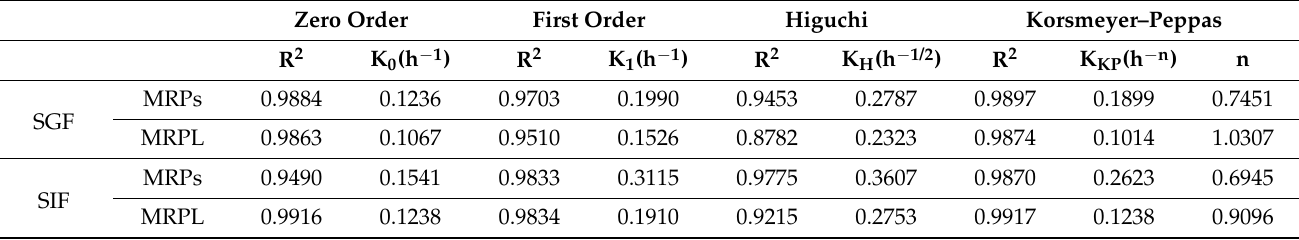
Table 1. Regression equation of four drug-release kinetic models in simulated gastrointestinal